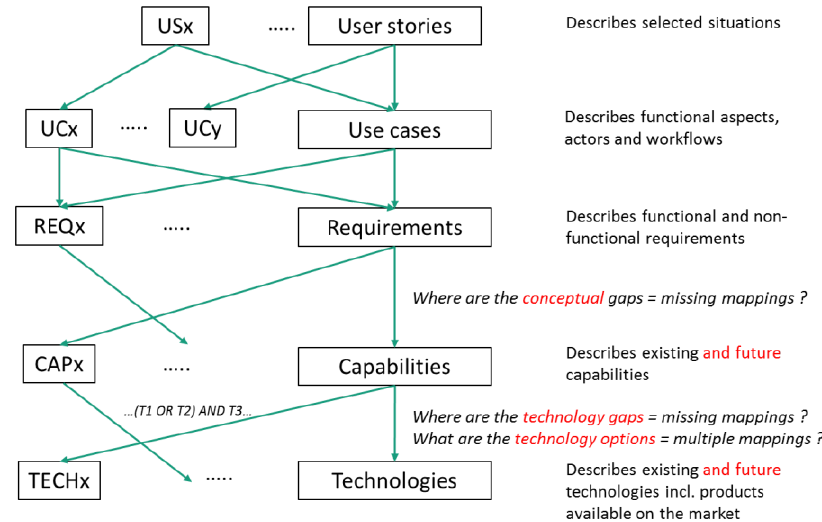
Figure 2. The five artefact levels of the SERVUS methodology.